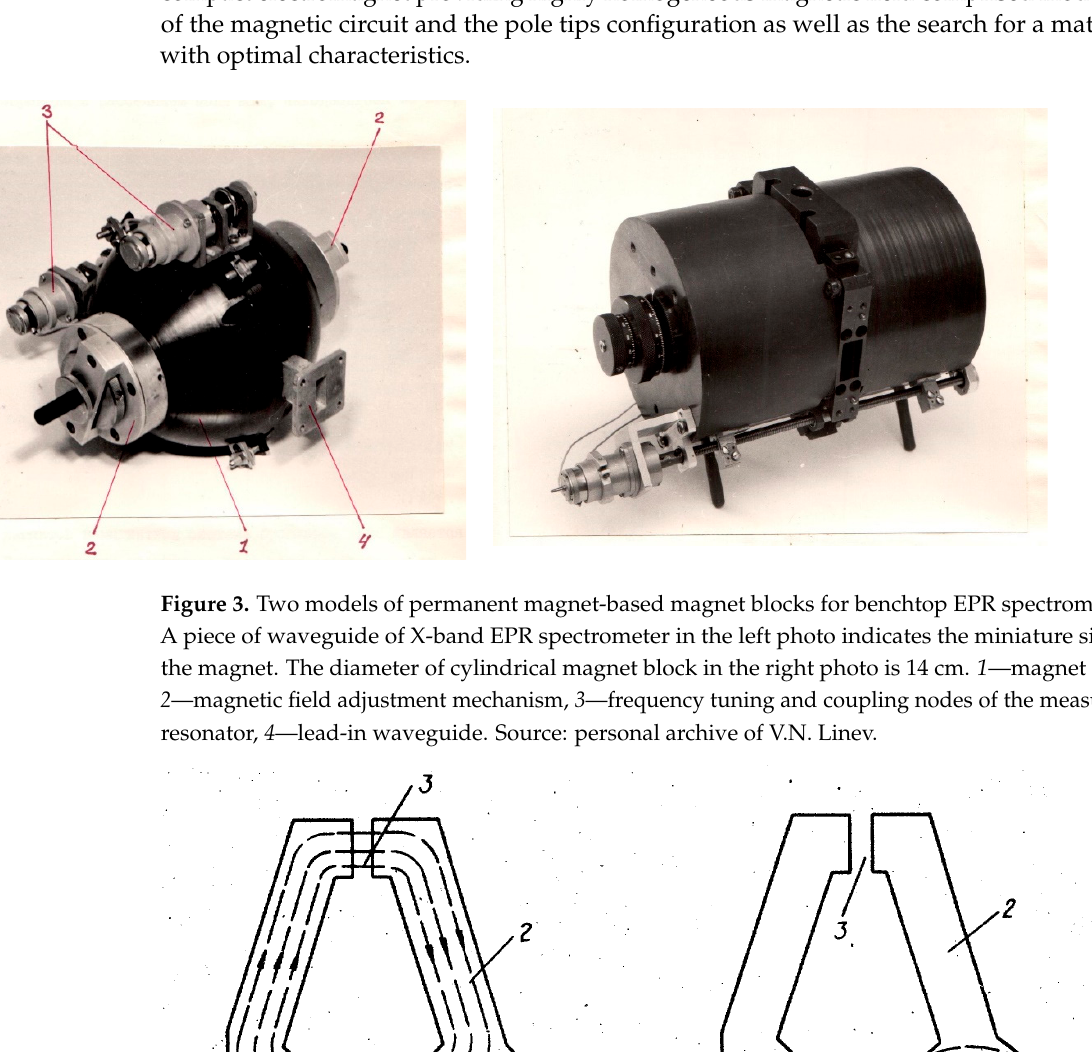
Figure 2. EPR resonator combined with the synchronous detector, dismantled ( a ) and assembled ( b ). Source: Personal archive of V.N. Linev.